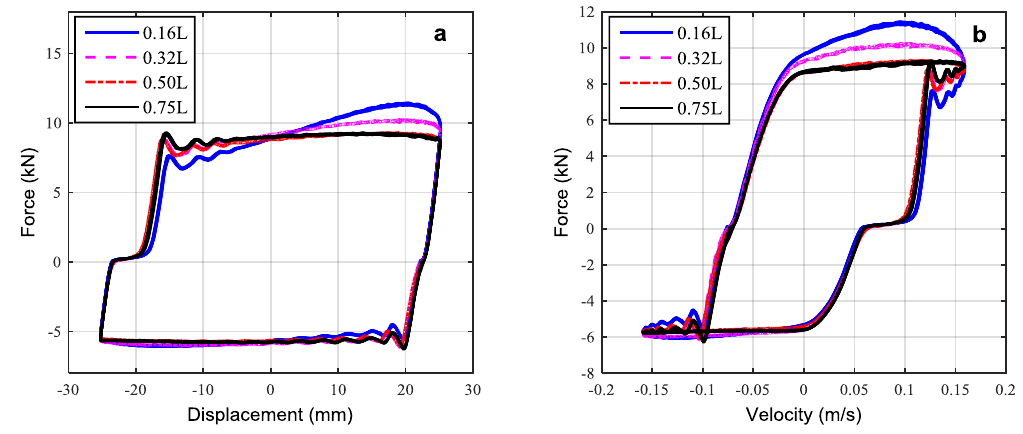
Figure 20. ( a ) Measured displacement-force loops; ( b ) measured velocity-force loops, at 0.16 L, 0.32 L, 0.50 L and 0.75 L accumulator capacities. 0.50 L and 0.75 L accumulator